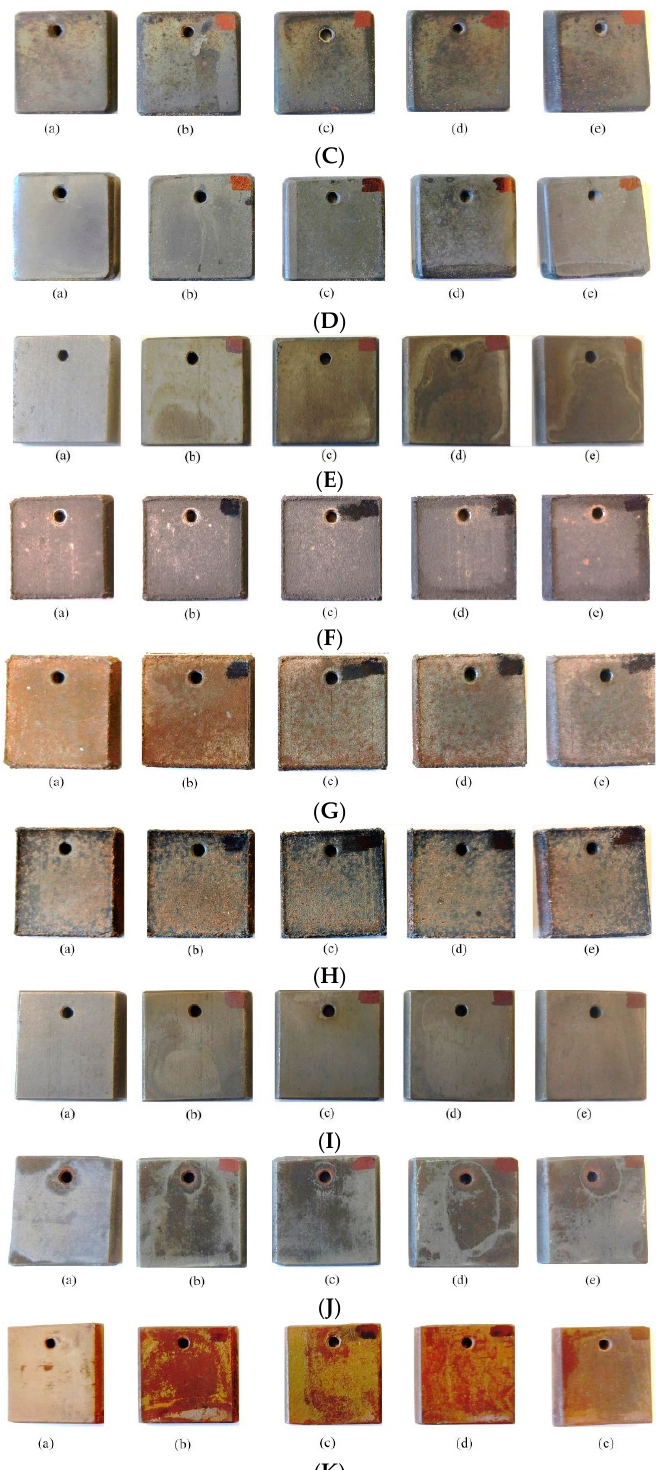
Figure A1. Photographs of the samples ( A ) 316-Bare, ( B ) 316-A, ( C ) 316-A-Sn, ( D ) 316-A-Z, ( E ) CS-Bare, ( F ) CS-A, ( G ) CS-A-Sn, ( H ) CS-A-Z, ( I ) CS-B, ( J ) CS-B-BN, and ( K ) CS-B-Z: ( a ) before salt corrosion testing; ( b ) after 24 h; ( c ) after 48 h; ( d ) after 96 h; and ( e ) after 168 h of exposure in low-temperature (at 220 ◦ C) corrosive environment. We moved the words in the original column (left) and re-edited the title, pls